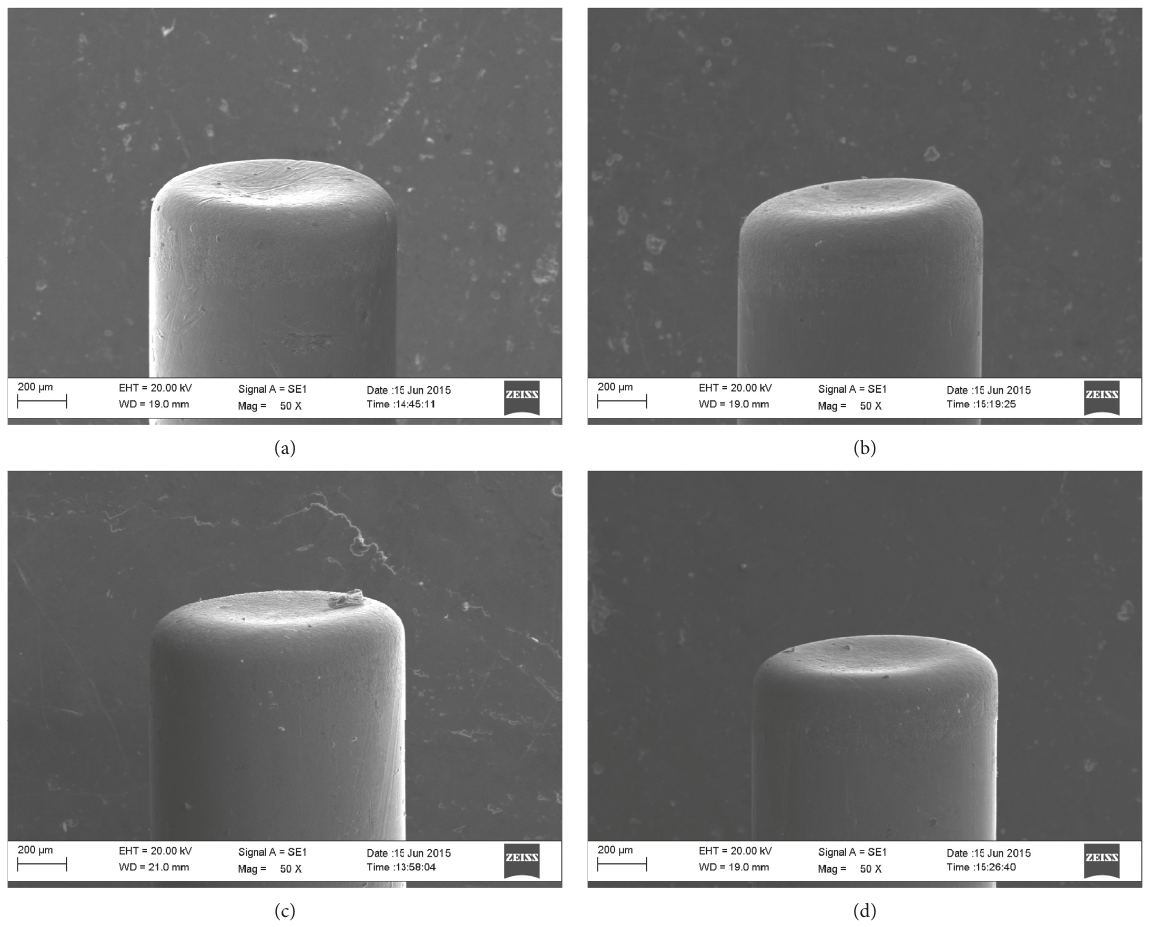
Figure 9: Electrode shape change with increasing pulse-off time (no. 4 of Table 1). (a) 1 μ s. (b) 10 μ s. (c) 20 μ s. (d) 200 μ